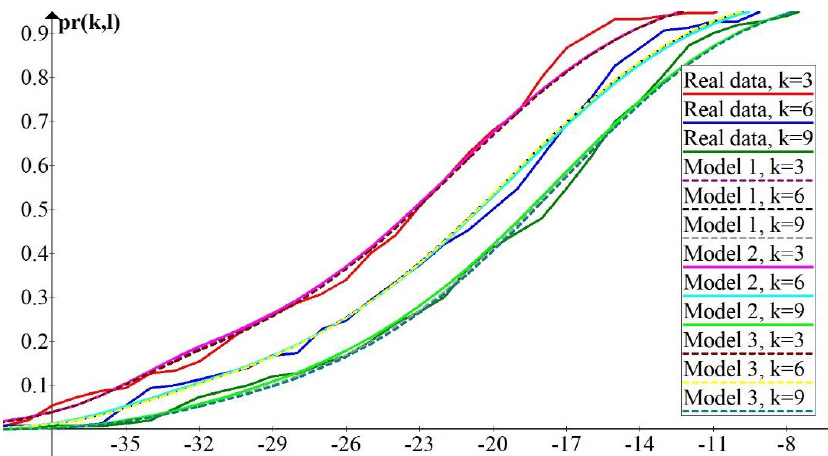
Figure 5. Probability pr ( k , l ) that at least at k stations the average daily WCI did not exceed the level l , Area 2, 1 February.